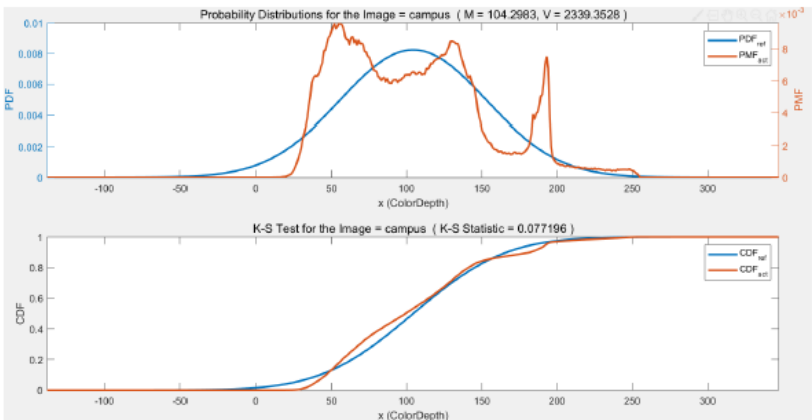
Figure 12. Histogram and Cumulative Distribution for Campus.